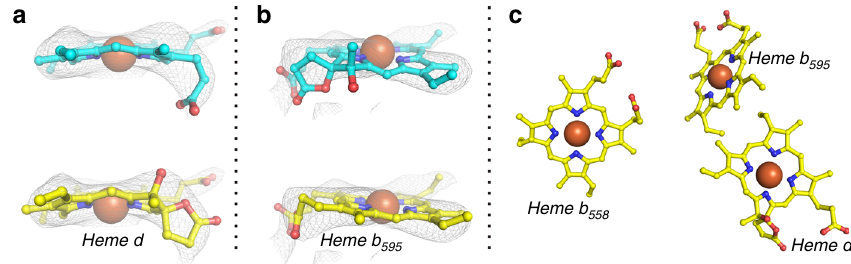
Fig. 3 Heme arrangement in CydA. Electron density maps of b 595 and d contoured at 1.5 σ show that, as compared to G. thermodenitri fi cans bd oxidase, b 595 and d exchange positions in CydA ( a , top). Heme b 595 as found in G. thermodenitri fi cans bd oxidase (blue carbons) does not fi t well into the electron density map, neither does heme d ( b top). Exchanging positions of both heme groups (yellow carbons) produces substantially better fi ts of hemes d ( a , bottom) and b 595 ( b , bottom), in particular for the hydroxyl group at the spiro substituted pyrrole of heme d. c Arrangement of heme groups in E. coli bd oxidase, periplasm: top of picture, cytoplasm: bottom of picture. The proposed arrangement is in line with the spectroscopic characterization of E. coli bd variants, in which Glu99 A and Glu445 A , both adjacent to the central Fe ion of heme b 595 and d, respectively, have been mutated 8,23 – 26 . Mutation of Glu99 A , adjacent to heme d according to our model, did not in fl uence the heme b 595 content, while mutations of Glu445 A , adjacent to heme b 595 according to our model, either in fl uenced solely the content of b 595 or of both hemes in question 8,23 – 26 . Mutation of Glu74 A , close to heme d according to the proposed model, eliminated the signal of heme d (Supplementary Fig. 7)